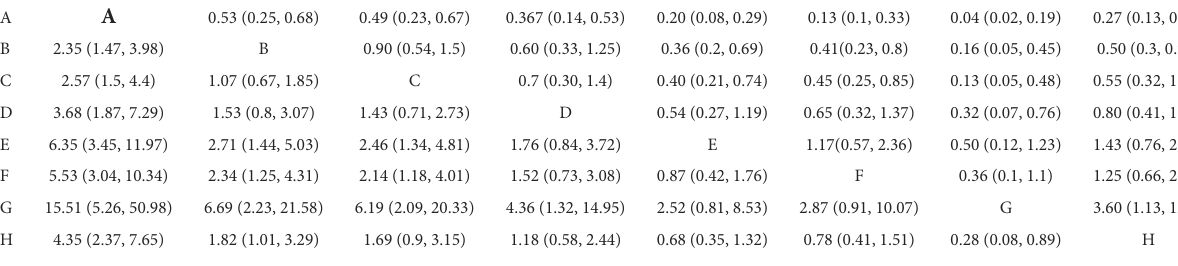
TABLE 2 Results of network analysis of different diseases.